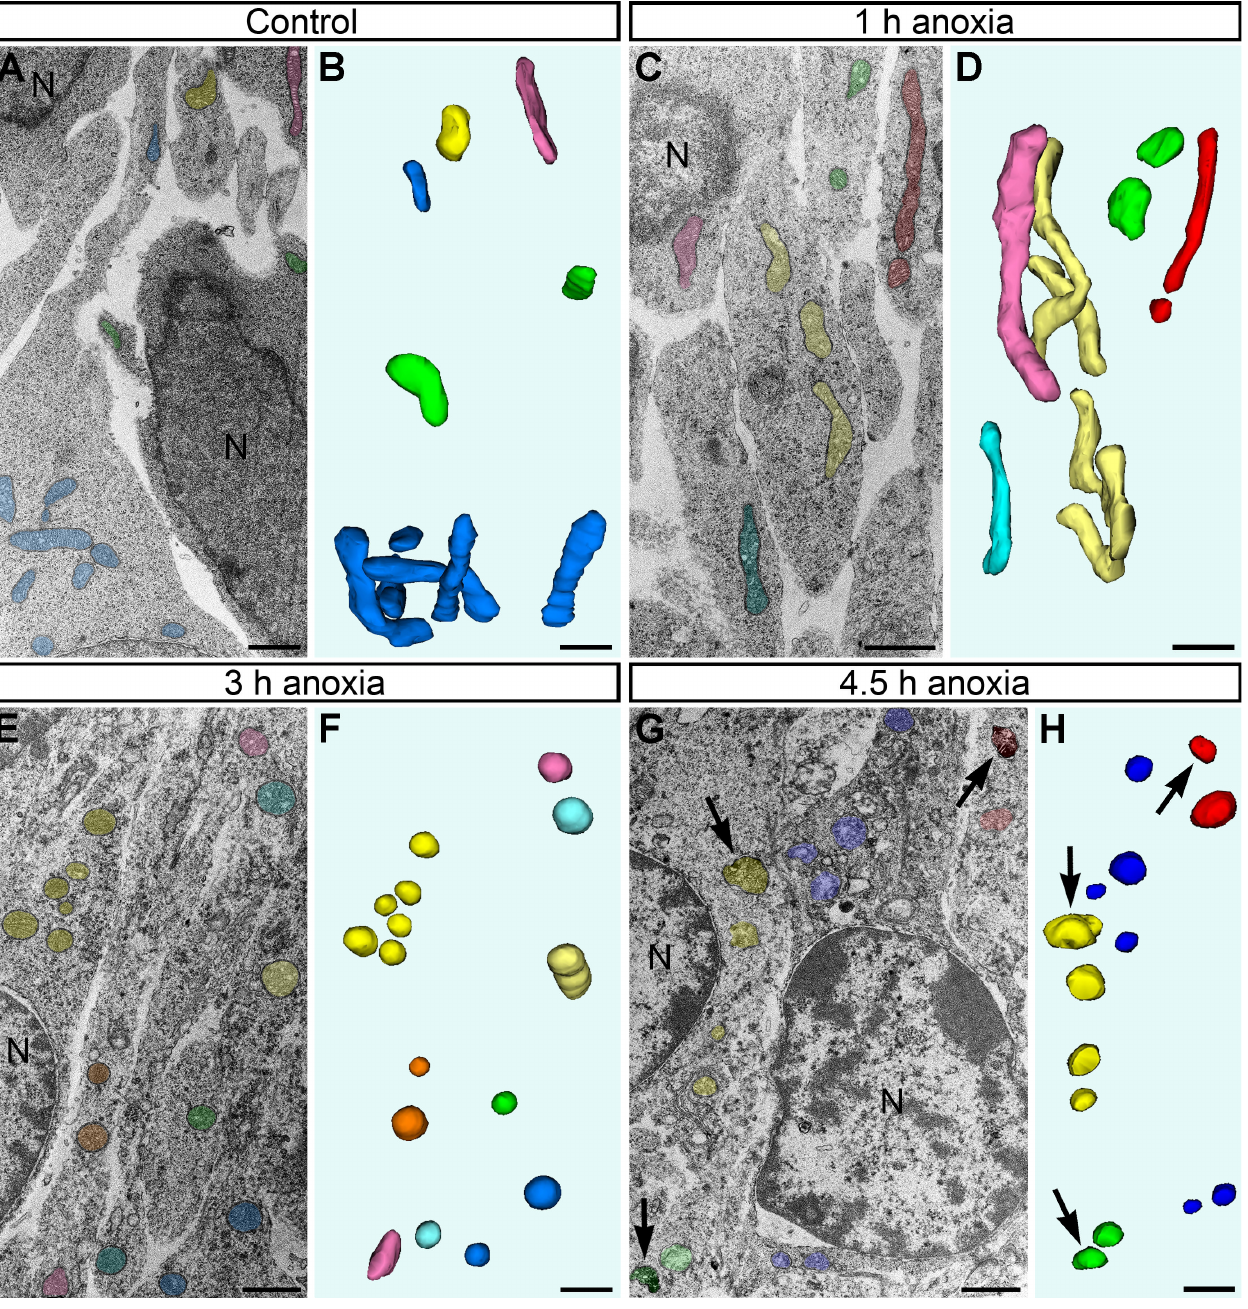
Figure 2. Electron micrographs of neuropil and 3D reconstructions of mitochondria from E13 mouse embryo cerebral SVZ fixed immediately after decapitation ( A , B ), after 1 h ( C , D ), 3 h ( E , F ), and 4.5 h anoxia ( G , H ). Mitochondria from distinct cell bodies or processes are shown in same colors in the micrographs and 3D images. Notice that long mitochondria are numerous in control brain and after 1 h anoxia; spherical mitochondria are predominant after 3 and 4.5 h anoxia. SLP2-immunopositive mitochondria (arrows) are numerous after 4.5 h of anoxia. Abbreviation: N, cell nucleus. Scale bars, 1 μ m.